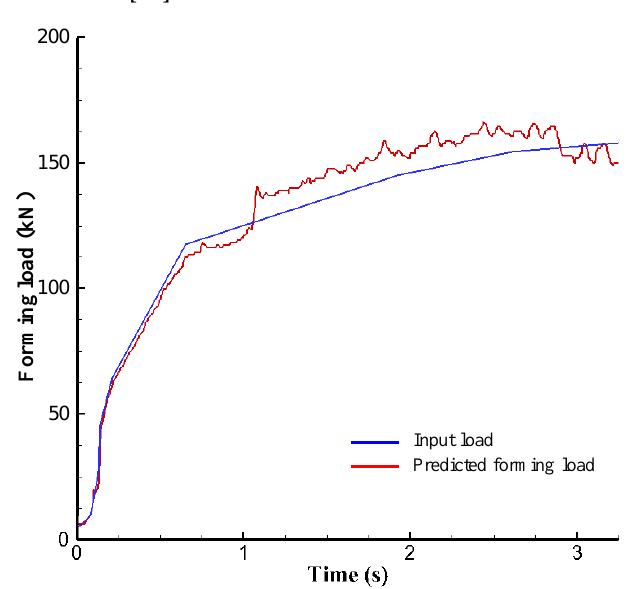
Figure 7. Experimental and predicted forming load – time curves.